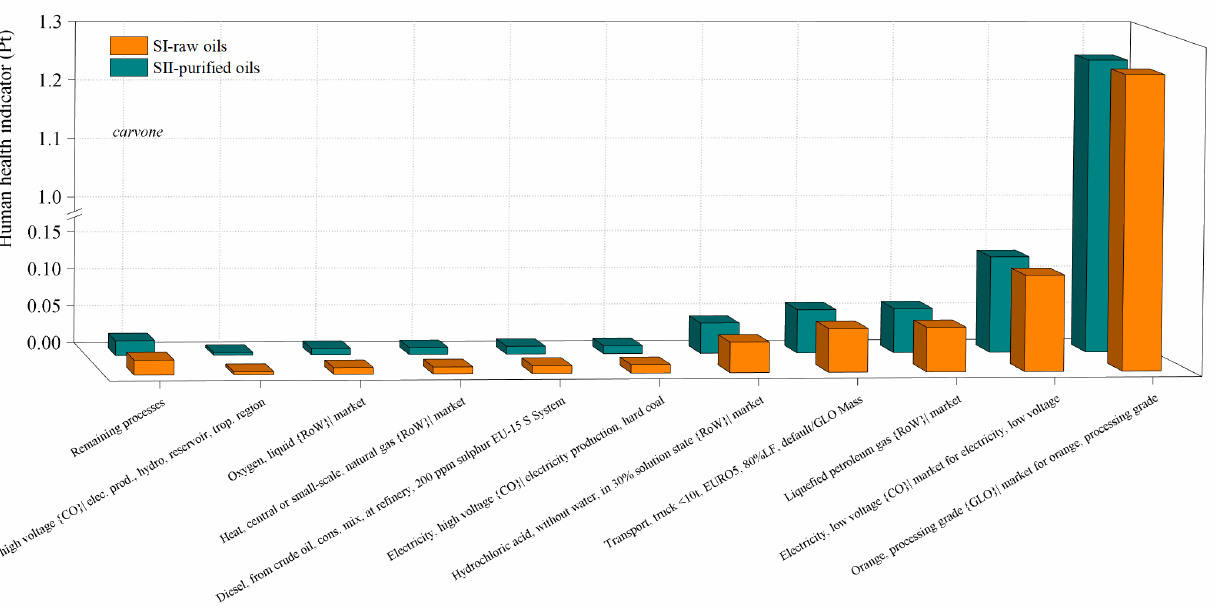
Figure 11. Comparison of the environmental impacts in the SI-raw-oils and SII-purified oils scenarios for the carvone process production by process contribution on the human health damage cate- gory. Assessment method: ReCiPe 2016 Endpoint (H) V1.04/World (2010) H/A.